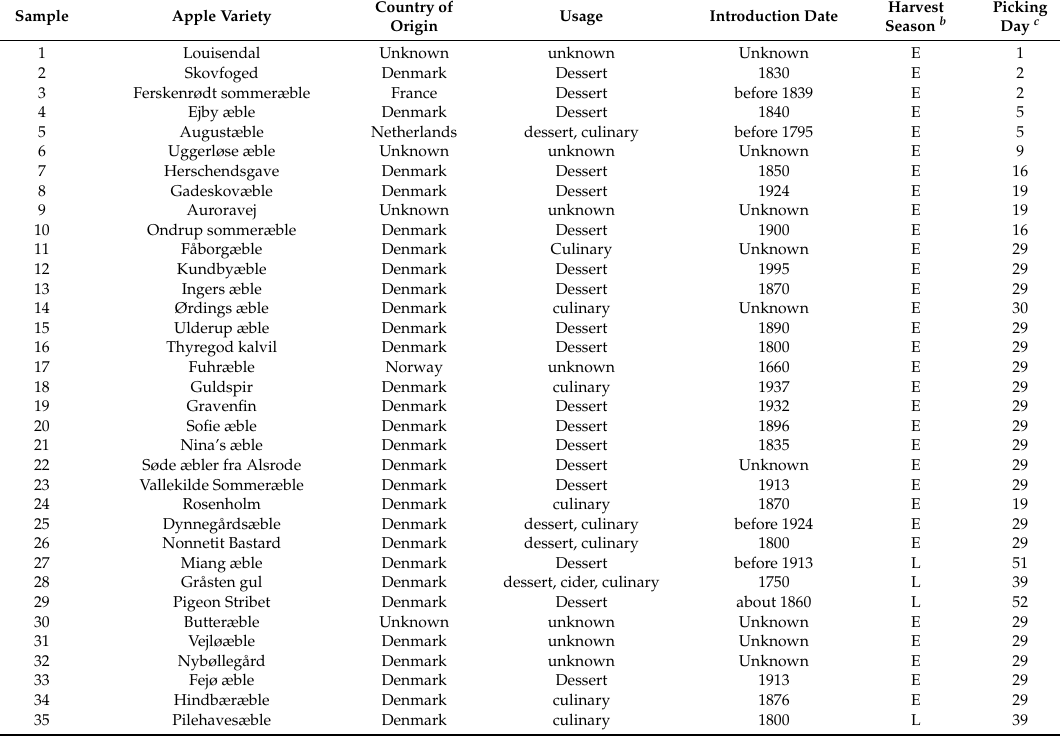
Table 1. Information about the 86 cultivars collected a